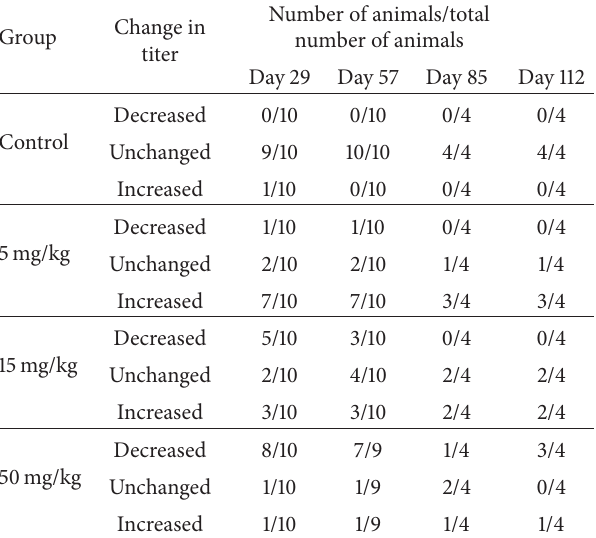
Table 1: Changes in titer by study day and by dose